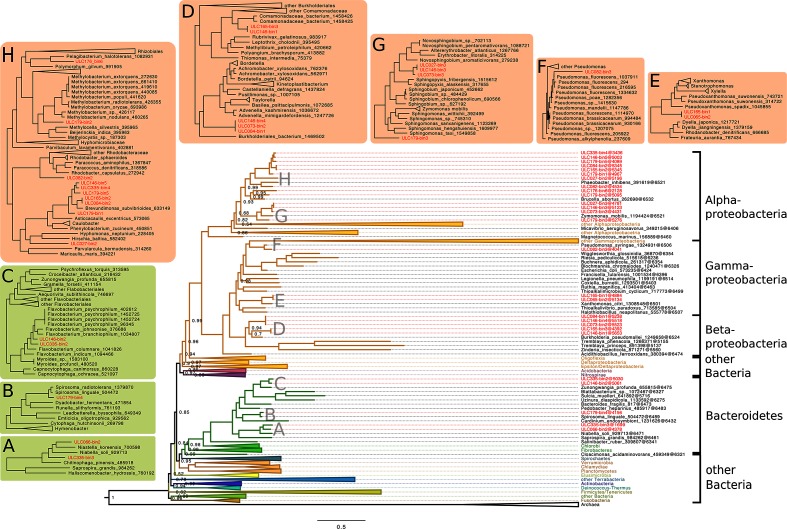
Phylogenomic tree of 196 broadly sampled Bacteria and Archaea showing the phylogenetic position of 27 microbiome genome bins. The Bayesian tree was inferred under the CAT+Γ4 model from a supermatrix made of 53 ribosomal genes (223 organisms×7060 amino-acid positions). PP values ≤1.0 are shown at the corresponding nodes. Surrounding subtrees are excerpts from a large maximum-likelihood tree inferred under the LG4X model from the full supermatrix (3501 organisms ×6613 amino-acid positions; Fig. S1). The 27 microbiome bins are indicated in red. Bacteroidetes bins are shown on a green background, whereas Protebacteria bins are shown on an orange background.